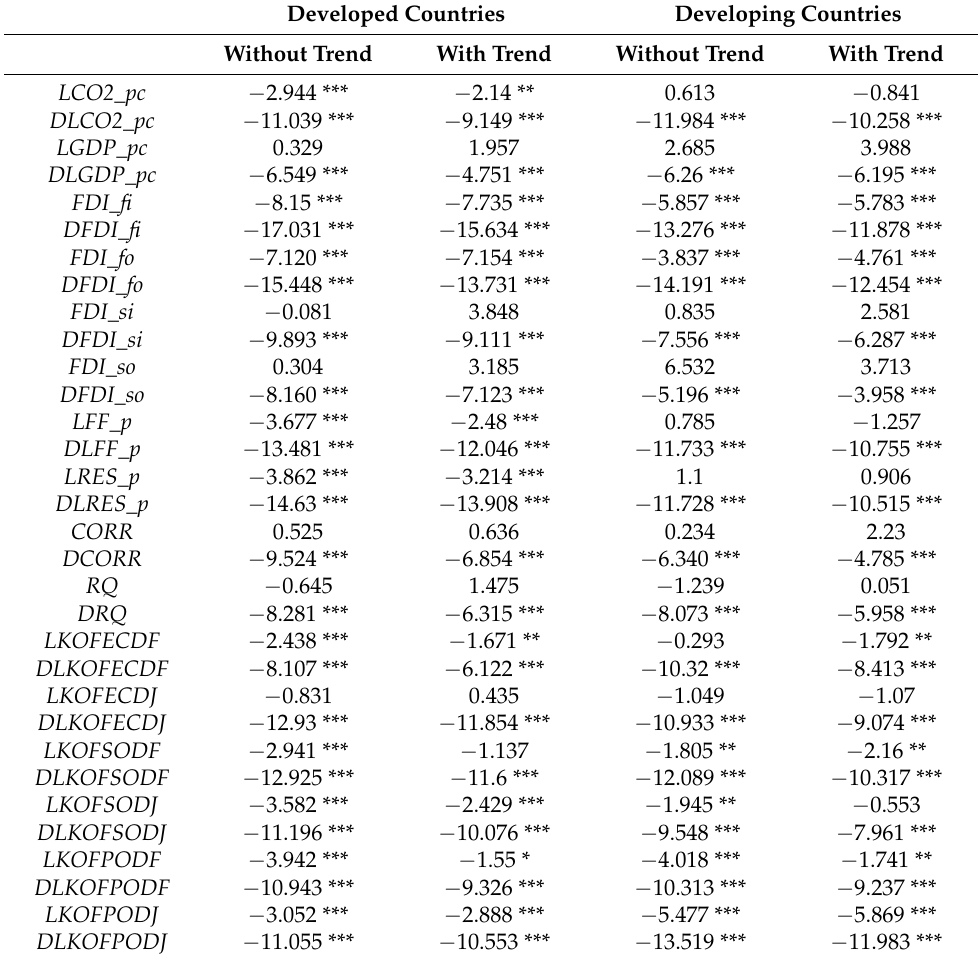
Table 7. Second-generation unit root test (CIPS) from 1996 to 2017 (CO 2